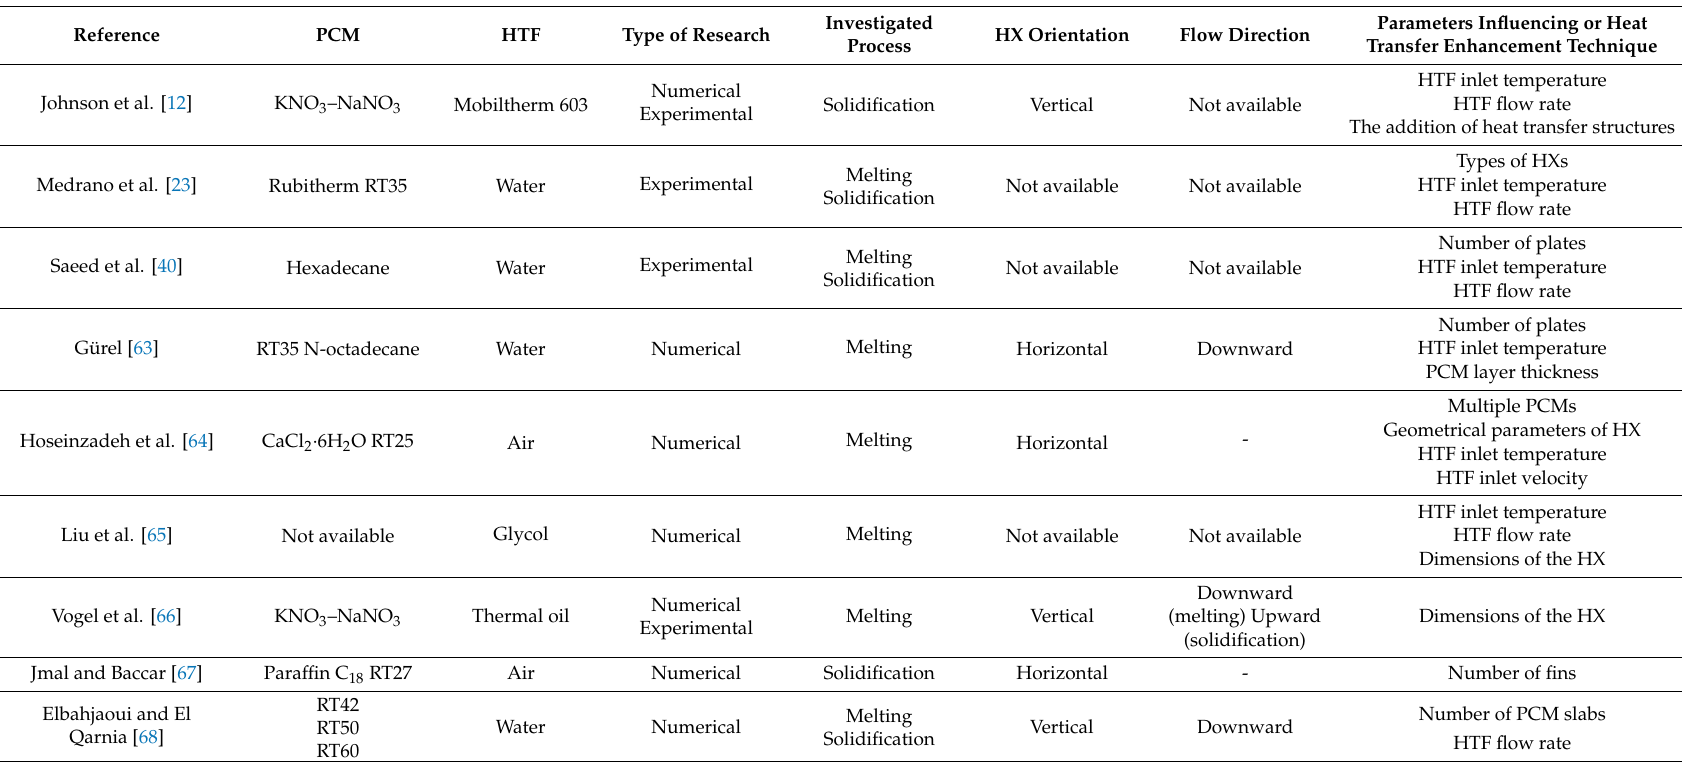
Table 2. Research on the plate heat